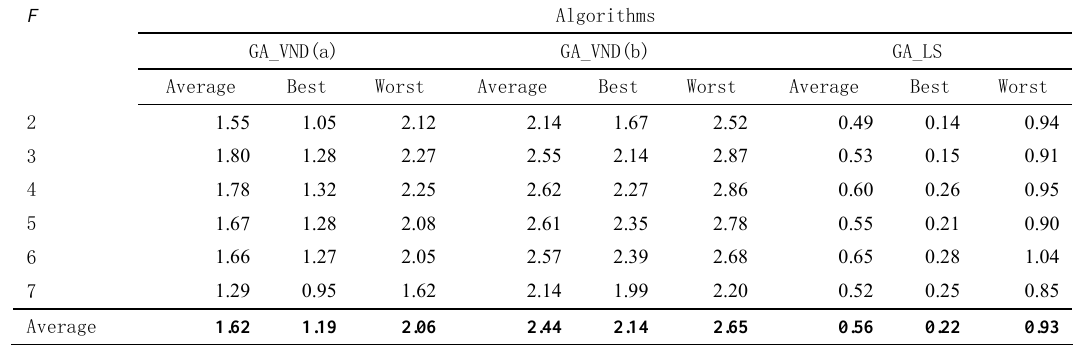
Table 5. Average RPD of genetic algorithms using CPU times of GA_LS as time limits F